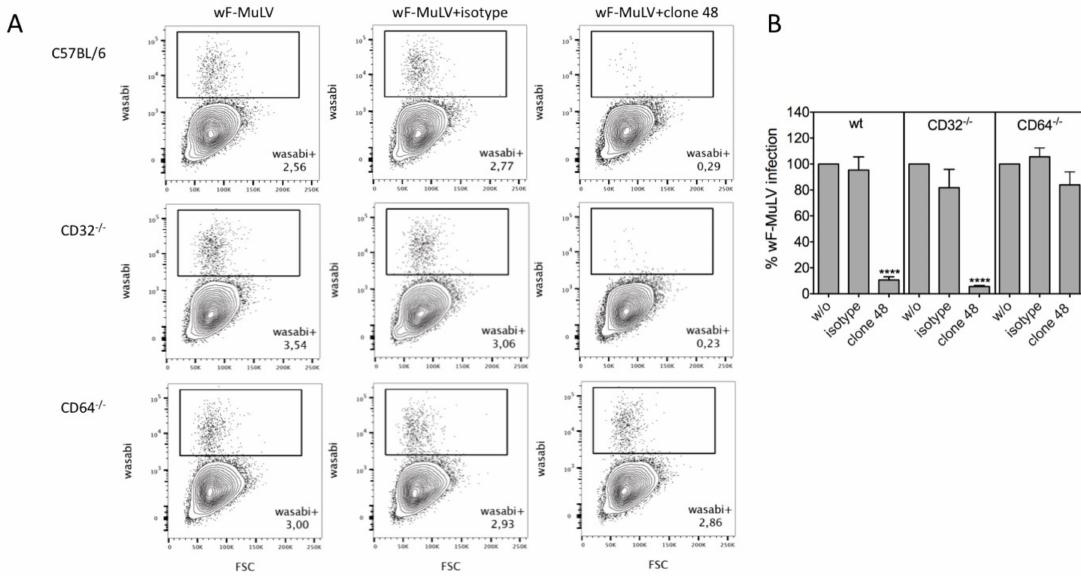
Figure 6. Abrogated infection by IgG-opsonized F-MuLV is restored in CD64-deficient DCs. DCs derived from the bone marrow of C57BL/6 wt or Fc γ RI (CD64 − / − ) or Fc γ RII (CD32 − / − )-deficient mice were infected with 5000 FFUs of mWasabi-encoding F-MuLV (wF-MuLV) in the presence or absence of clone 48 or isotype antibodies. Cells were further cultivated for 2 days at 37 ◦ C and mWasabi-positive infected cells were determined by FACS. ( A ) Density plots showing mWasabi-positive cells from a representative experiment and ( B ) data representing mean ± SEM of four independent experiments are shown (activation measured in control samples ( w / o ) was set to 100%). Data were analyzed by GraphPad PRISM software using ANOVA followed by Sidak’s multiple comparison